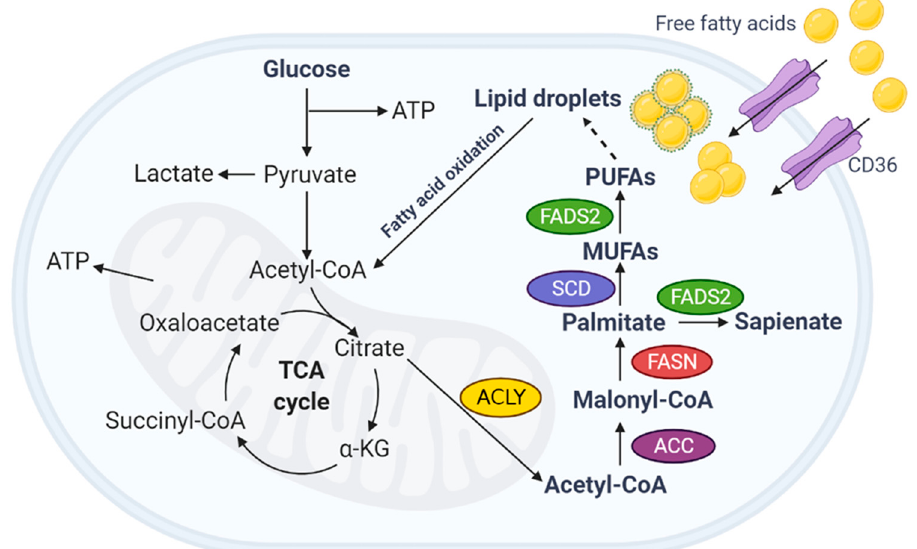
Figure 1. Fatty acid metabolism in the TME of ovarian cancer. Fatty acid-mediated lipid metabolism in TME is well controlled by cancer cells, adipocytes, and stromal cells with complex processes, leading to ovarian cancer metastasis and drug resistance. CAF, cancer-associated fibroblast; NK cell, natural killer cell; TAM, tumor-associated fibroblast; DC, dendritic cell; SREBP-1, sterol regulatory element binding protein 1; FABP, fatty acid binding protein; FASN, fatty acid synthase; SIK2, salt-inducible kinase 2; MCP-1, monocyte chemoattractant protein-1; TIMP-1, tissue inhibitor of metalloproteinase-1; and TGF- β 1, transforming growth factor β 1.